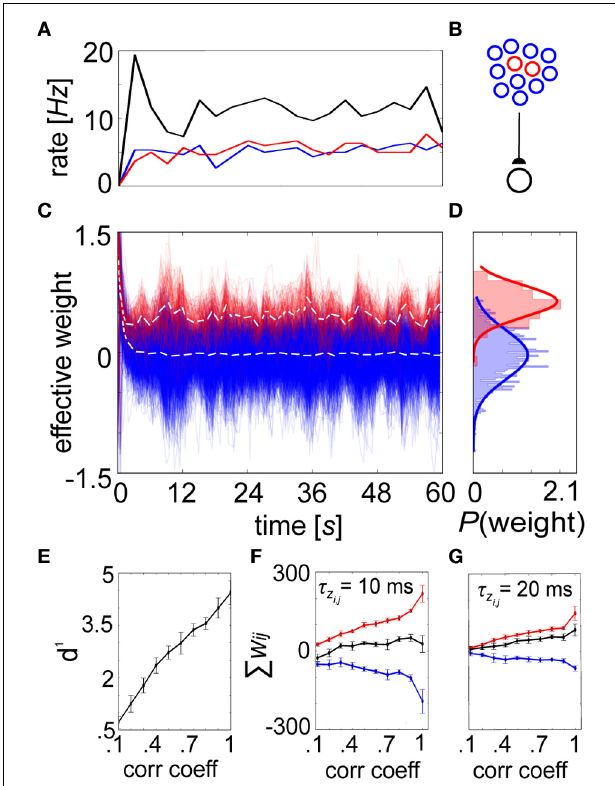
FIGURE 7 | A shift in the weight distribution of correlated neurons arises from structured input. (A) Progression of averaged rates of firing (3s bins) for the externally stimulated uncorrelated (blue) and correlated (pictured C = 0.2, red) presynaptic neurons, along with the postsynaptic (black) neuron they drive in the network. (B) Setup involves 900 uncorrelated and 100 correlated presynaptic neurons that drive one postsynaptic cell. (C) Synaptic strengths recorded every 100ms from the correlated group gradually specialize over time vs. their uncorrelated counterparts, resulting in a change in the mean distribution of weights (white dotted lines for each, here C = 0.2). (D) Weight histograms plotted for the final time epoch are unimodal and approximately normally distributed ( C = 0 . 2, μ 0 = − 0 . 03, μ 0 = 0 . 34 and σ 0 ≈ σ + = 0 . 18). (E) The separation between these distributions is expressed as d 1 , which increases as a function of the input correlation coefficient. (F) Summed weights for the correlated (red), uncorrelated (blue), and combined (black) in the final epoch as a function of C . (G) Same as in (F) but with τ zi and τ zj increased by a factor of 2. In both instances, the combined weights remain relatively constant around w ij = 0, although lower time constants induce more substantial differences between the correlated and uncorrelated weights. Error bars depict the standard deviation gathered from 50 repeated